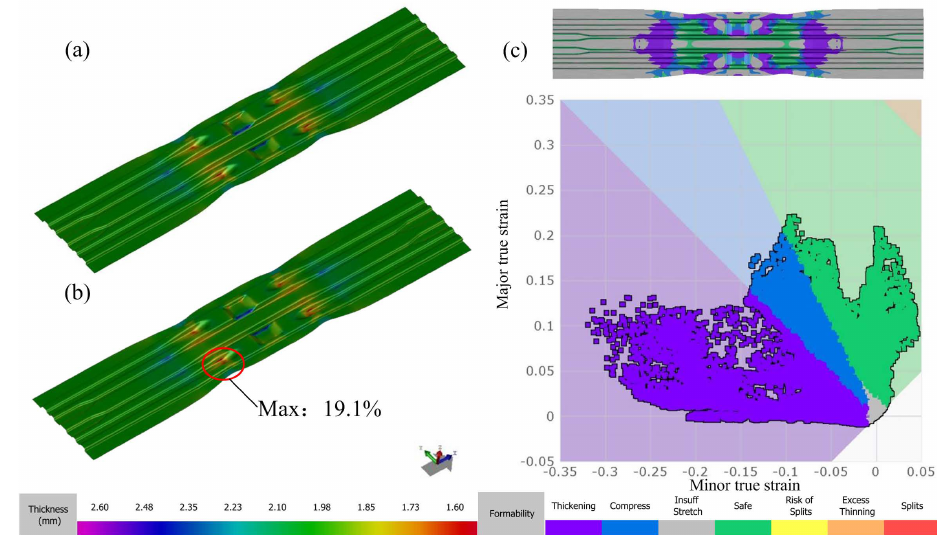
Figure 9. Thickness distribution of the blank: pre-forming ( a ) after quenching ( b ) and forming limit diagram of the blank ( c ).